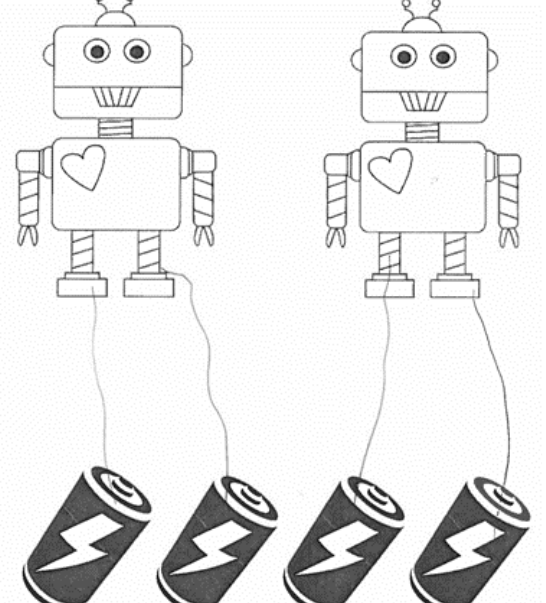
Figure 1. Example of a correct mathematics story response. Note . Student work showing a correct distribution of four batteries to two robots. This response received a score of 8, meaning that all of the batteries were distributed correctly and fairly, and no partitions were necessary.